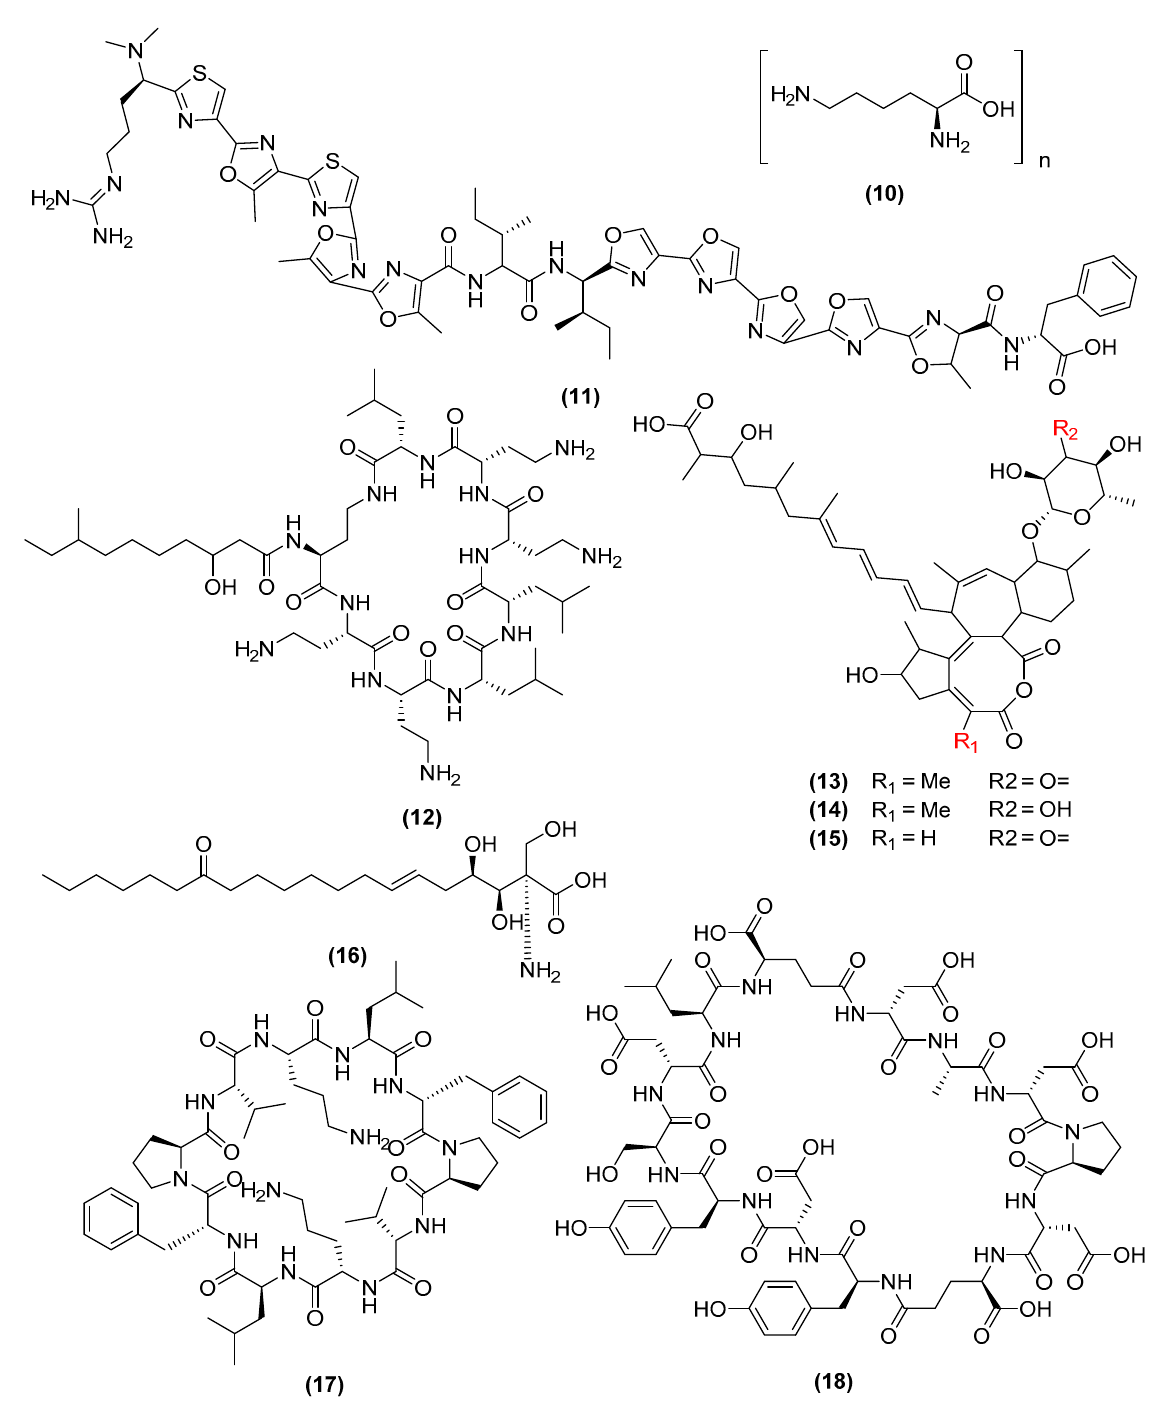
Figure 5. Chemical structures of ε -poly-L-Lysine ( 10 ), plantazolicin ( 11 ), octapeptin B ( 12 ), au- rantinin B ( 13 ), aurantinin C ( 14 ), aurantinin (D) ( 15 ), myriocin ( 16 ), gramicidin A ( 17 ), and gramicidin S ( 18 ).